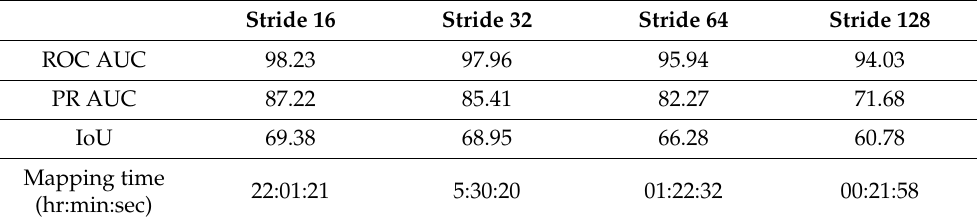
Table 5. Receiver operation characteristic (ROC AUC), precision-recall area under the curve (PR AUC), intersection over union (IoU), and mapping time using different stride